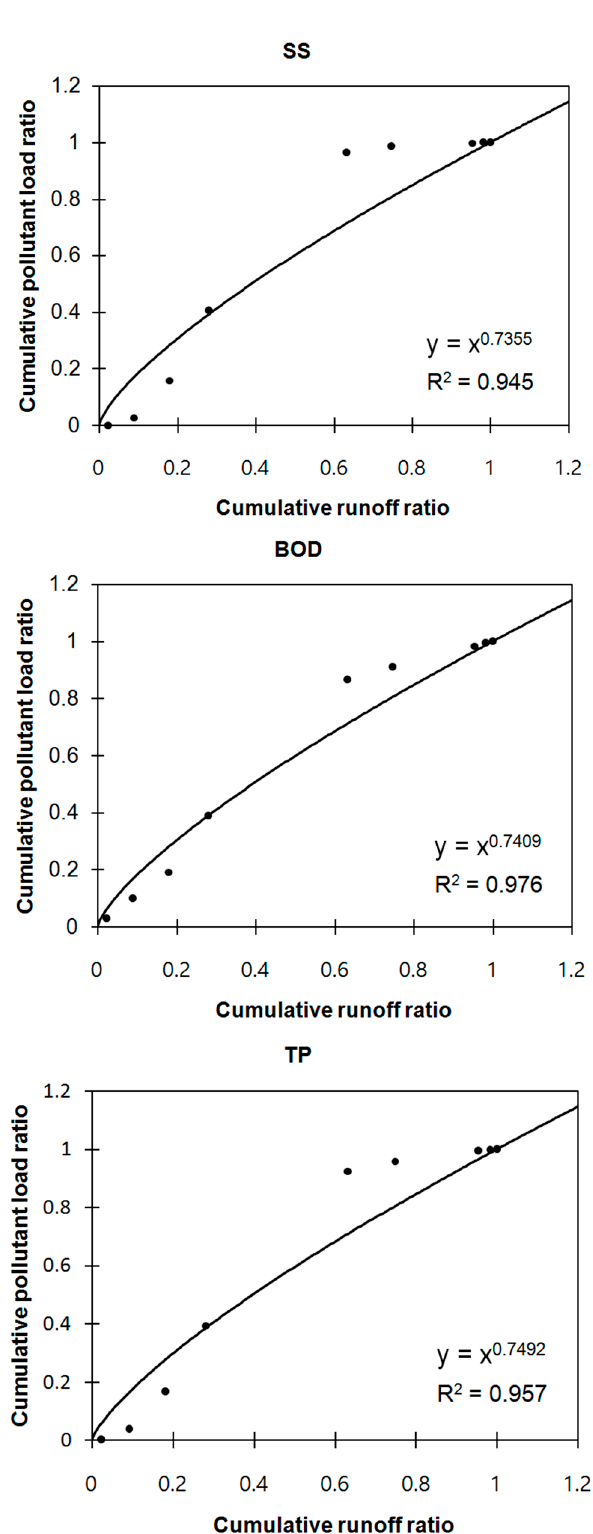
Figure 10. M(V) curve fitting using the power function for Jungjohangcheon (16–17 July 2016). Figure 10. M ( V ) curve fitting using the power function for Jungjohangcheon (16–17 July